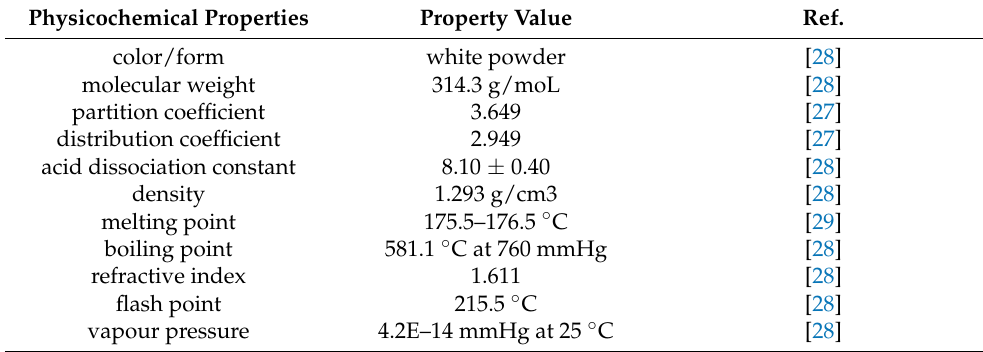
Table 2. Physicochemical properties of